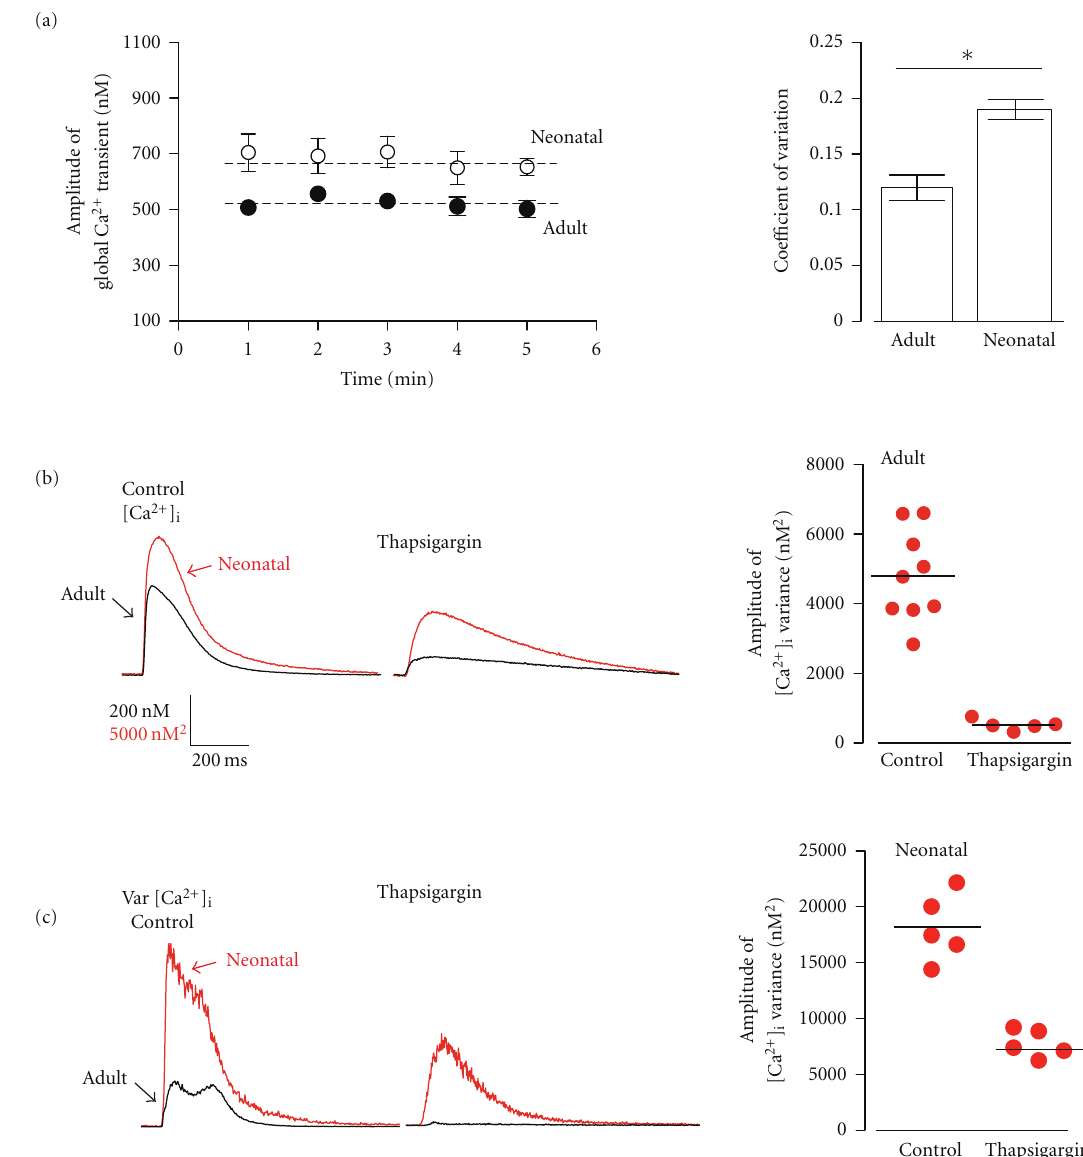
Figure 1: Beat-to-beat fidelity of EC coupling in ventricular myocytes. (a) Average peak amplitude of action potential evoked (1Hz) global Ca 2+ transients (nM) from adult (closed circles) and neonatal (open circles) ventricular myocytes measured at 1 minute interval for five minutes and corresponding coe ffi cient of variation among the adult and neonatal myocyte population. Dashed line represents average peak [Ca 2+ ] i signal over 5 minutes. (b) Representative [Ca 2+ ] i transient of adult and neonatal myocytes. (c) Representative [Ca 2+ ] i signal variance of adult and neonatal ventricular myocytes and the distribution of peak amplitude [Ca 2+ ] i variance (nM 2 ) of adult ventricular myocytes in the presence and absence of the SR Ca 2+ pump inhibitor thapsigargin (1 μ